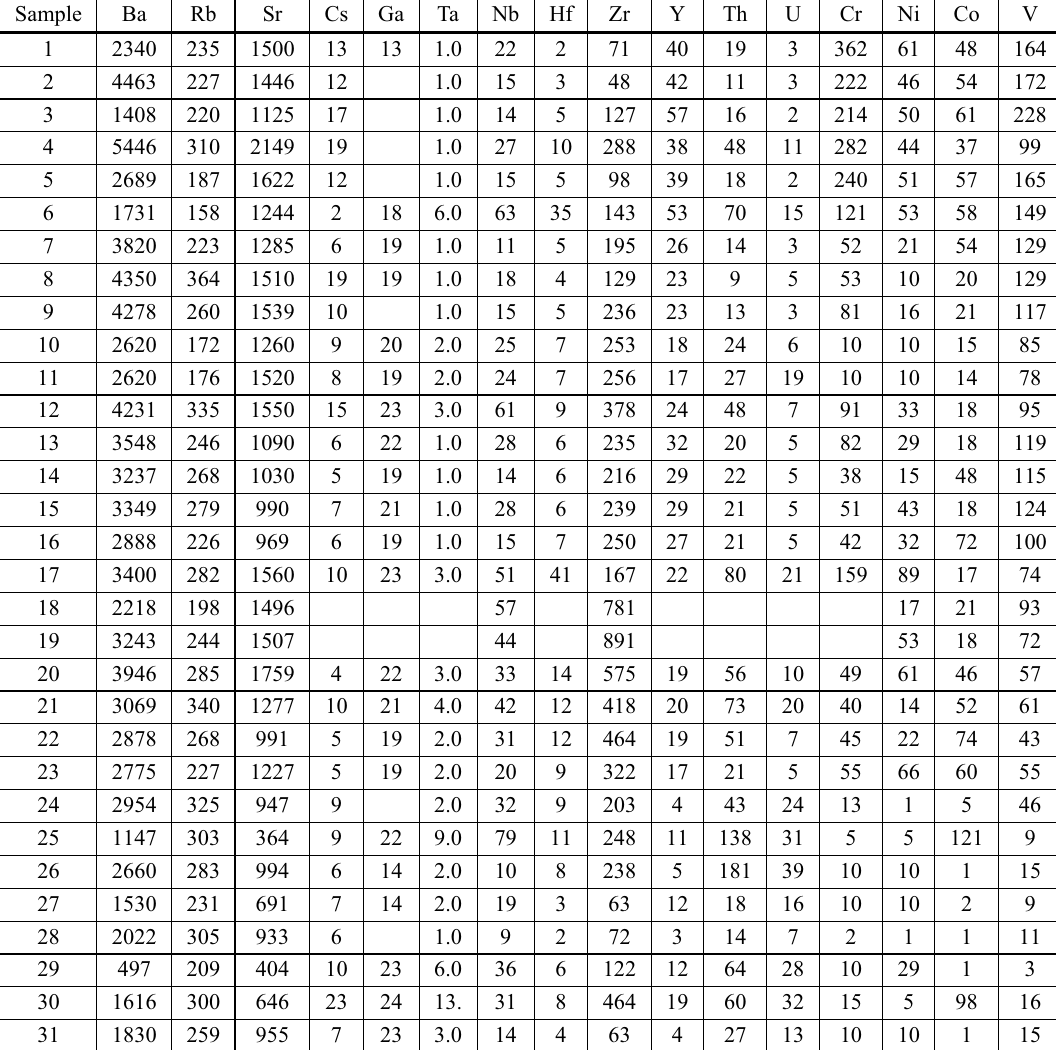
Trace element data, ICP-MS determinations – ppm – for the Piquiri Syenite Massif studied